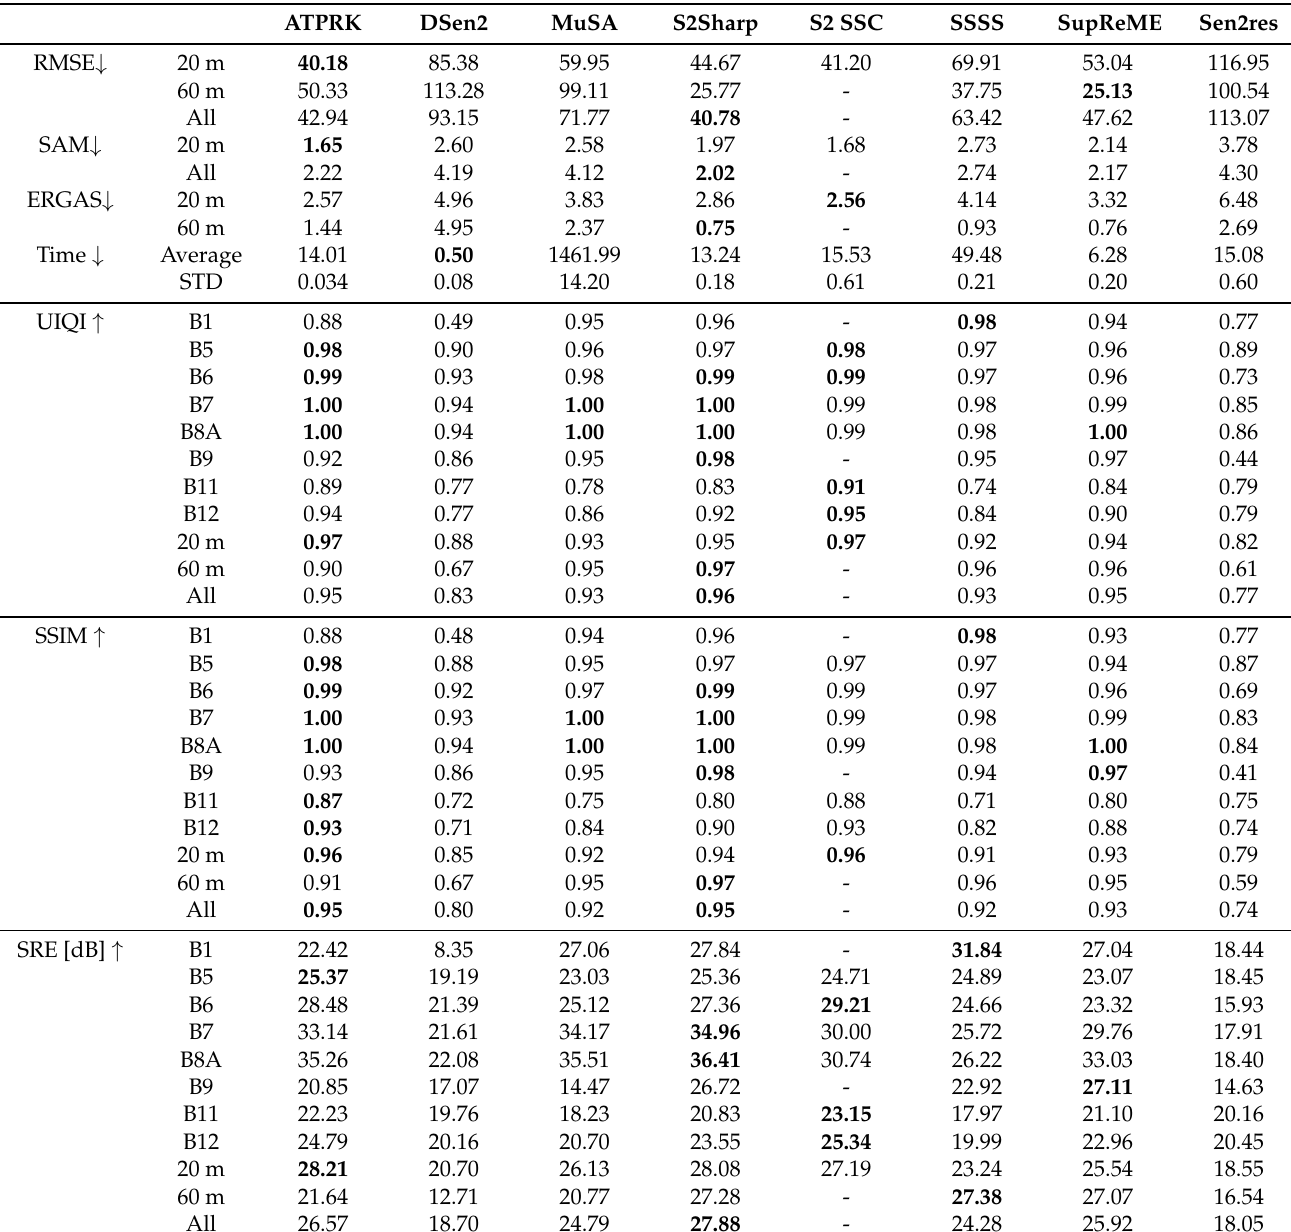
Table 3. Evaluation using S2 data simulated from AVIRIS image of Escondido. The best results are given in bold typeface. ATPRK DSen2 MuSA S2Sharp S2 SSC SSSS SupReME